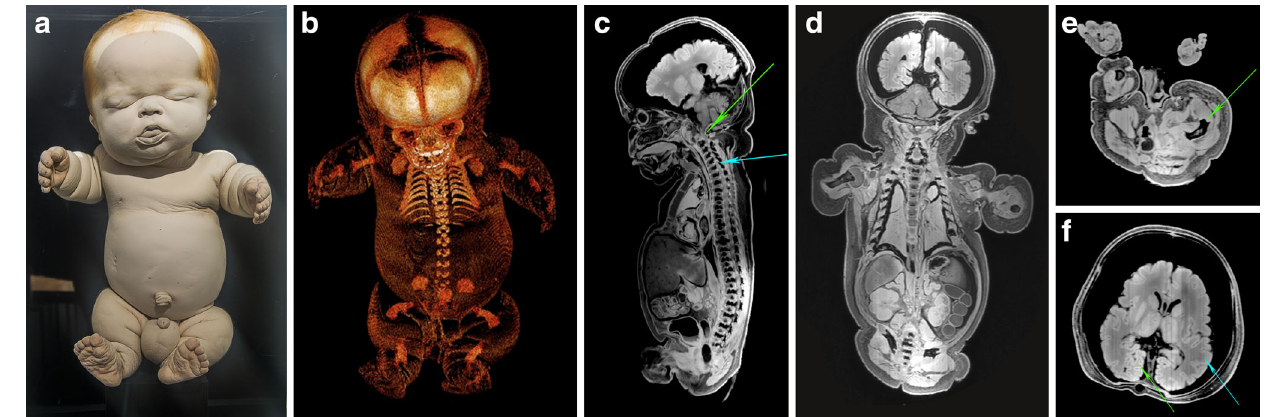
Fig. 3 a Photograph of the full-term fetus of case 1. b Three-dimensional reconstructed skeleton based onthe CTdata.Although there was severely diminished bone calcification, CTimages visualised extremely shortened ribs, short and small scapulae and iliac bones, and femoral and humeral bowing. c Sagittal T1-weighted MR image which showed a small fora- men magnum with slight cranio-cervical caudal transition ( green arrow ), platyspondyly of the vertebra with short vertebral arches resulting in spinal canal stenosis ( turquoise arrow ). d Coronal T1-weighted MR im- ages showed a severely hypoplastic thorax with presumably severe lung- hypoplasia. e Transverse T1-weighted MR image on the level of the